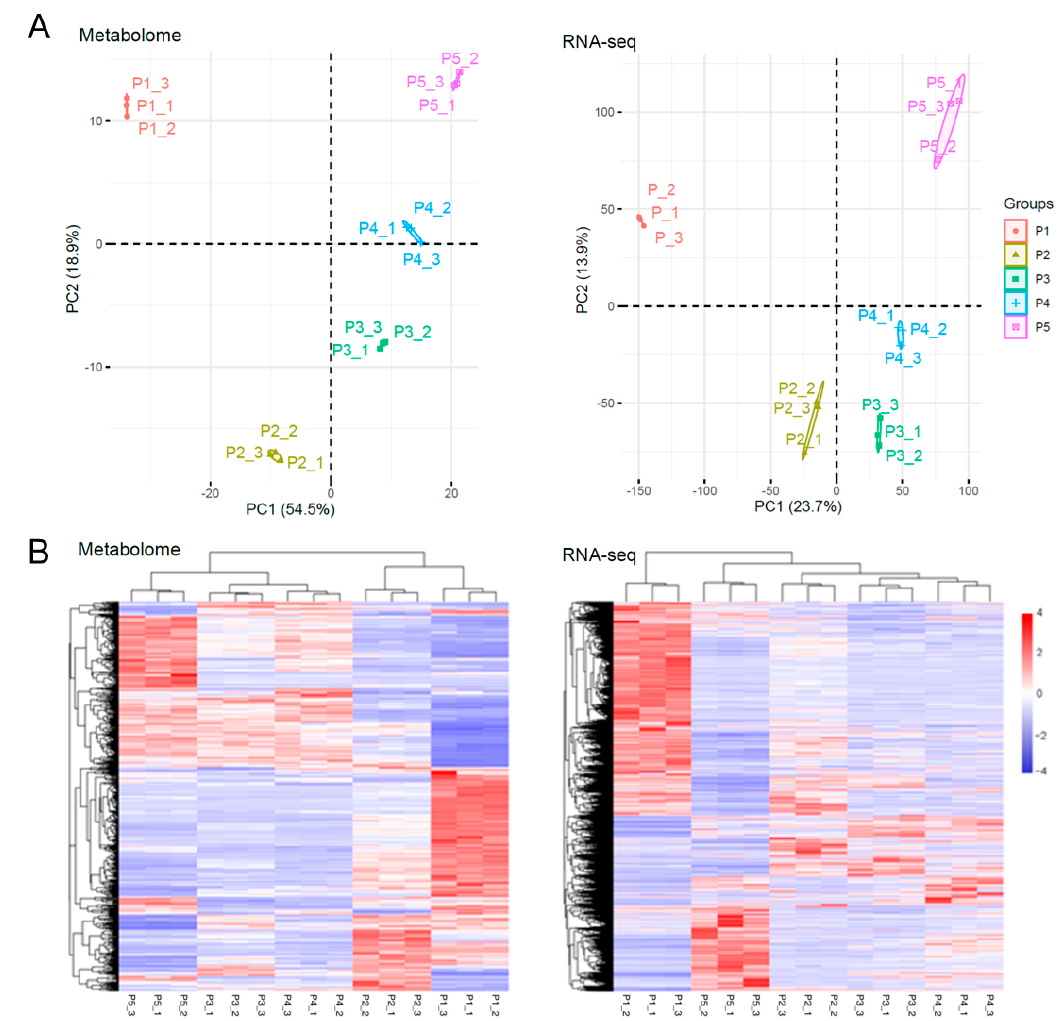
Figure 3. PCA of samples and cluster analysis of DAMs and DEGs in endopleura. ( A ) PCA of all 15 endopleura samples was conducted based on the relative contents of all detected metabolites ( left ) and RNAseq FPKM ( right ). ( B ) Cluster analysis of DAMs ( left ) and DEGs ( right ). The color scale ( − 4 to 4) represents the calculated Z ‐ score.